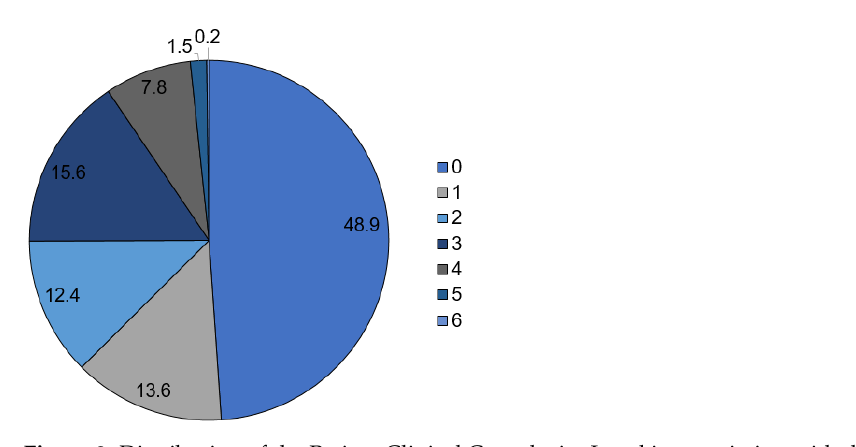
Figure 2. Distribution of the Patient Clinical Complexity Level in association with the Post-COVID syndrome given in percentages.